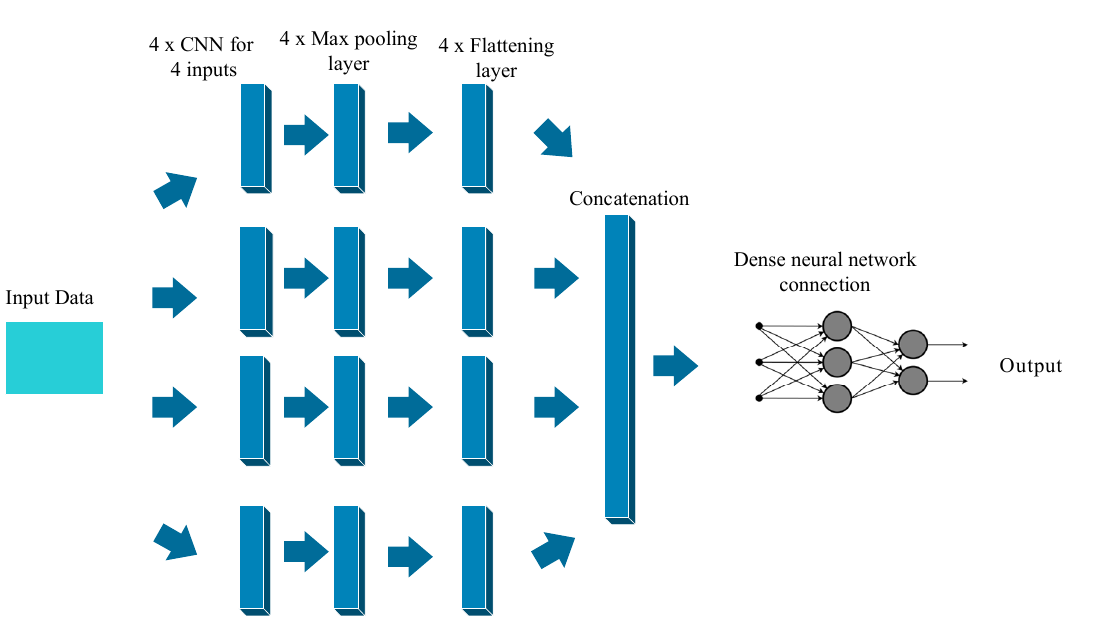
Figure 2. Multi-headed CNN structure.